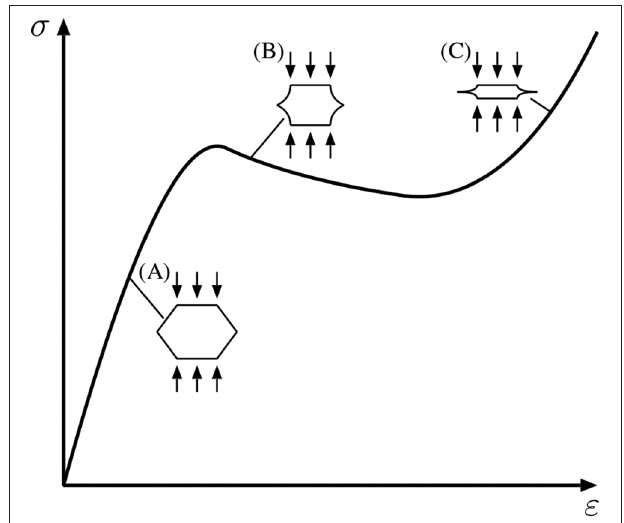
FIGURE 3 | Stress σ vs. strain ε behavior of conventional cellular core materials under compression. (A) Small deflection linear behavior; (B) elastic buckling of cell walls causing destiffening; (C) restiffening from cell